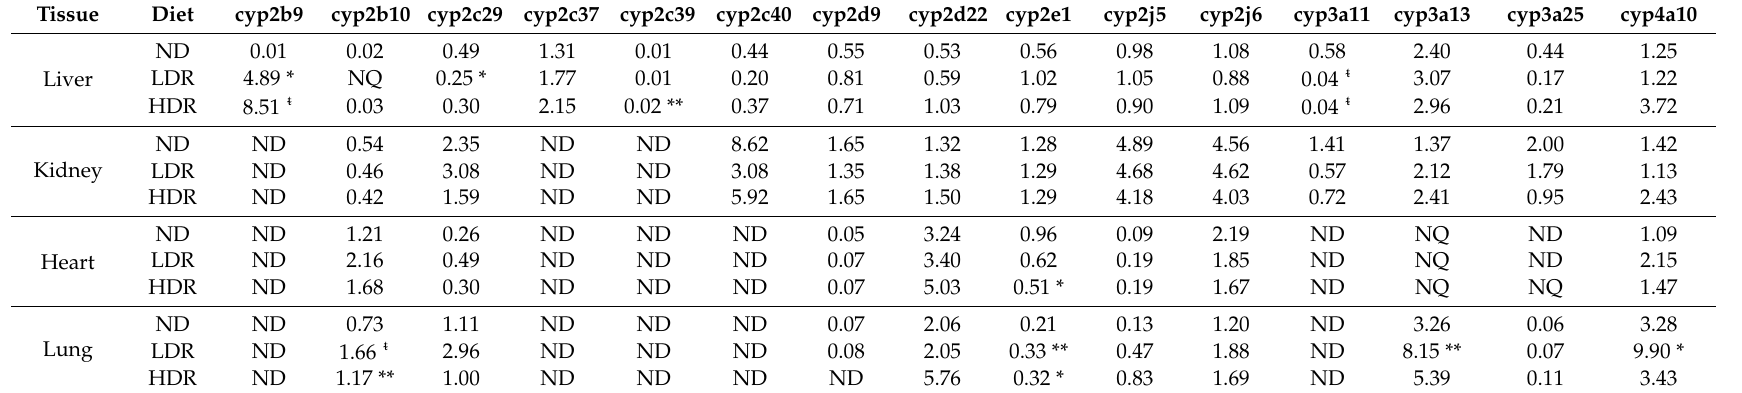
Table 1. Relative mRNA transcripts for each cyp isoform in C57B/6 mice microsomes according to diet group.